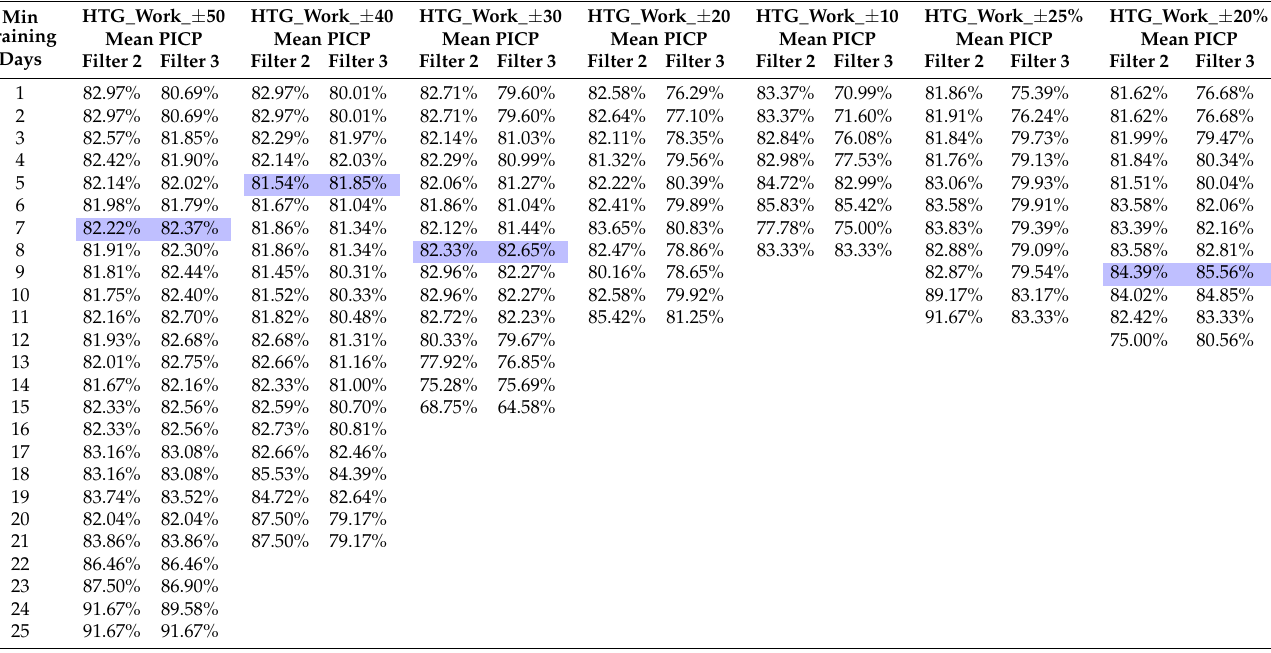
Table A1. Definition of the minimum number of training days required for each criterion within Filter 3. The highlighted cells show when the mean PICP of each criterion of Filter 3 improves the mean PICP of Filter 2. Min